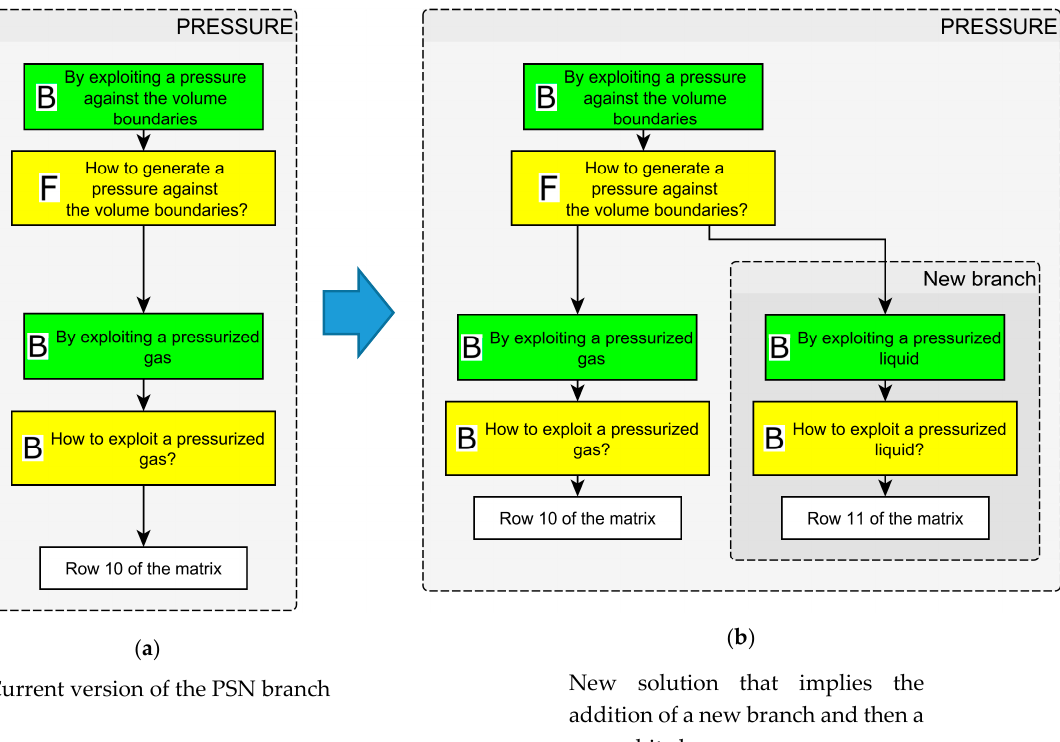
Figure 12. Illustrative example to show how to add new branches in the PSN, in order to keep track of new ideas that cannot be described in the available rows of the chart (i.e., the available red boxes in the PSN).